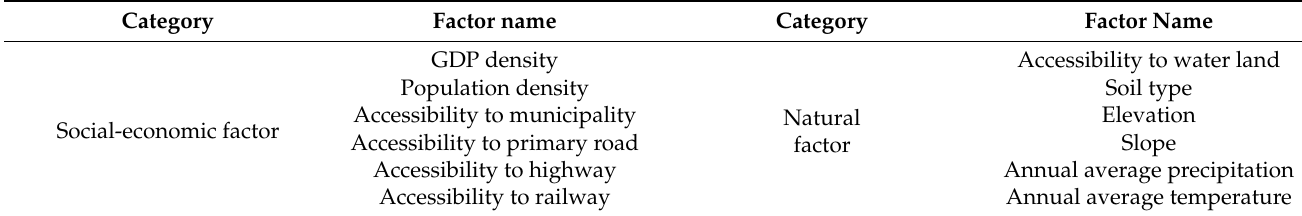
Table 1. Driving factors for land use change simulation.